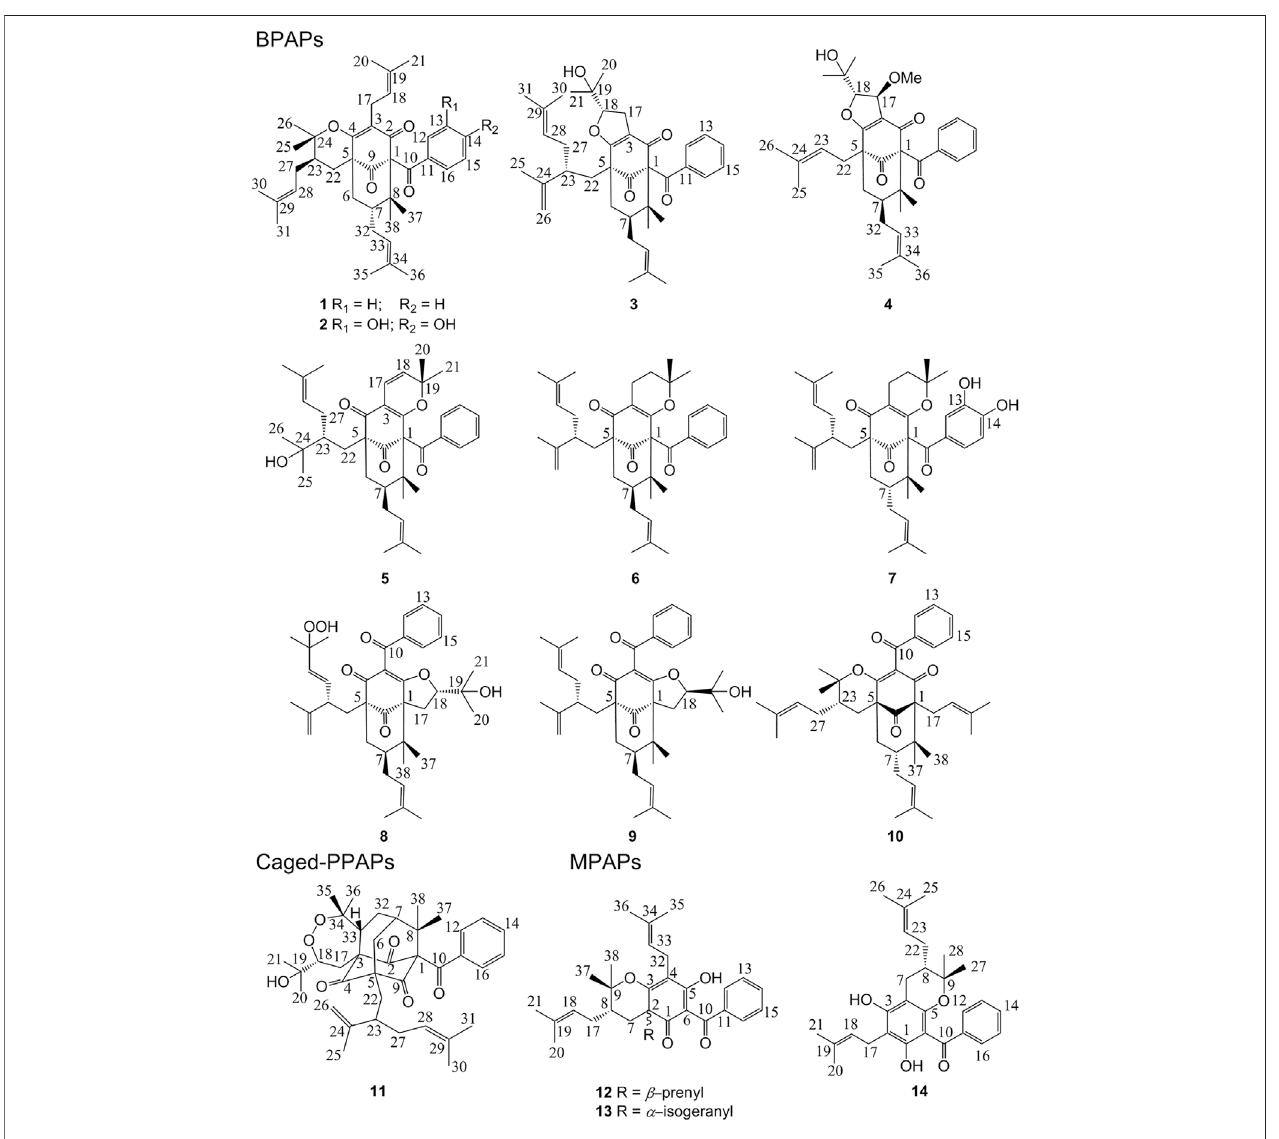
FIGURE 1 | Chemical structures of PAPs ( 1 – 14 ) from G . multi fl ora .